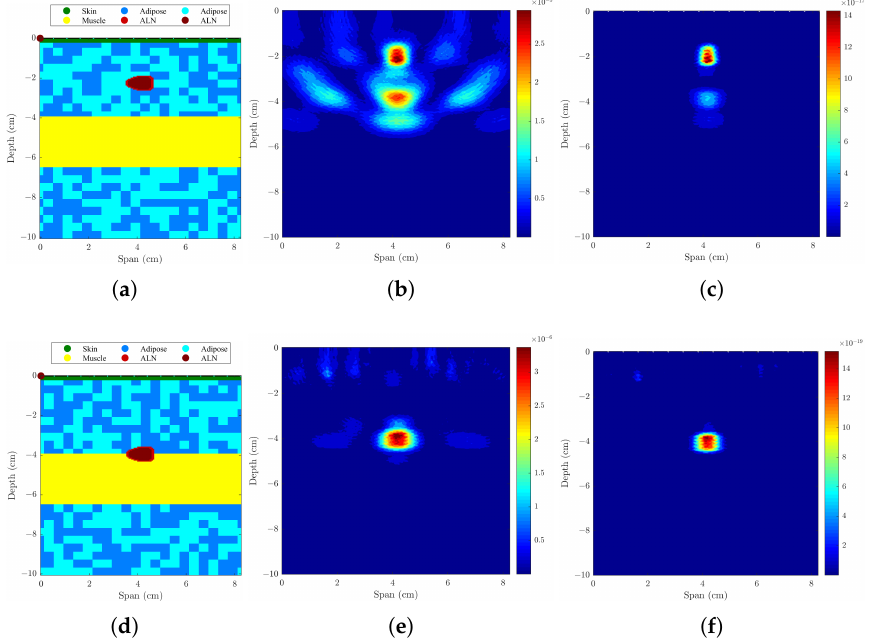
Figure 6. Models and corresponding backscattered energy results from the implemented MWI system of an axillary region model with a muscle layer and an ALN at different depths: ( a – c ) shallow ALN and ( d – f ) deep ALN. The figure shows the simulated models in ( a , d ), and the corresponding backscat- tered energy results using DAS and CR-DMAS beamformers in ( b , e , c , f ), respectively, after applying Bond’s artifact removal algorithm. The high intensity regions in ( b , c , e , f ) indicate the detection of the lymph node.